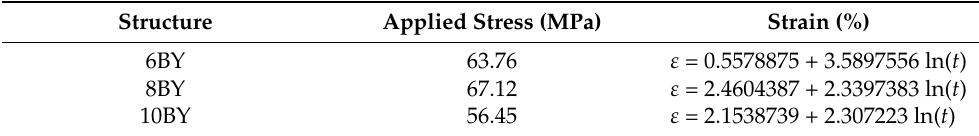
Table 3. Mean true strain within 7200 s for PVA braided architecture ( σ 0 = 0.16 σ u ).